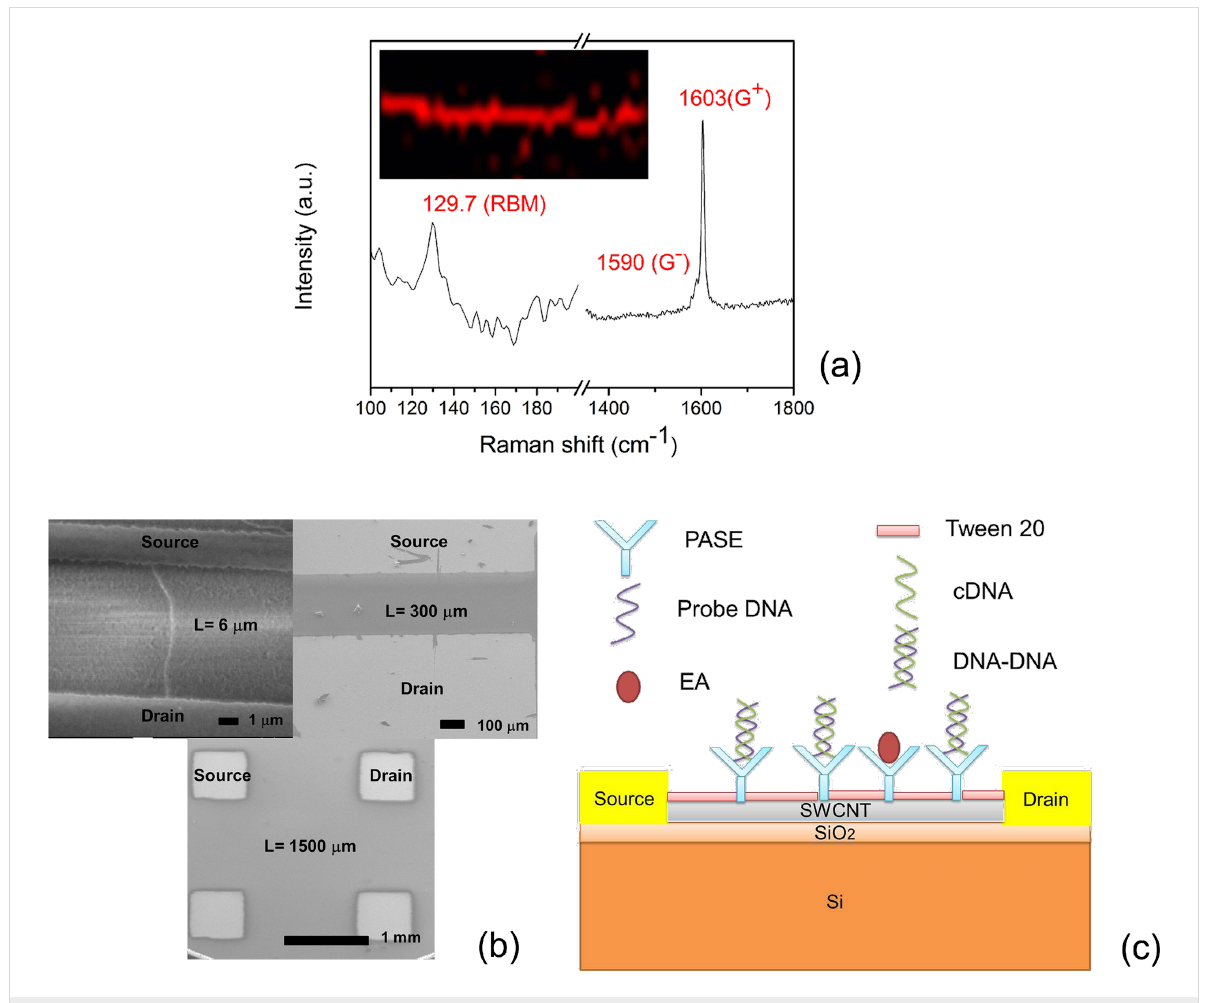
Figure 2: (a) The Raman spectrum of a 1 cm long SWCNT with a RBM at ≈ 129.7 cm − 1 and a G-band with G − and G + peaks at 1590 cm − 1 and 1603 cm − 1 , respectively, under 633 nm wavelength excitation. The inset shows the Raman mapping image of the SWCNT. (b) SEM image of as-prepared SWCNT-based FETs with channel lengths of 6 µm (short), 300 µm (long) and 1500 µm (ultra-long), shown with source and drain elec- trodes. (c) Schematic setup for DNA hybridization detection using SWCNT-based FET. cDNA represents the complementary target single stranded DNA and DNA–DNA represents the double stranded DNA formed by complementary base pairing between probe DNA and